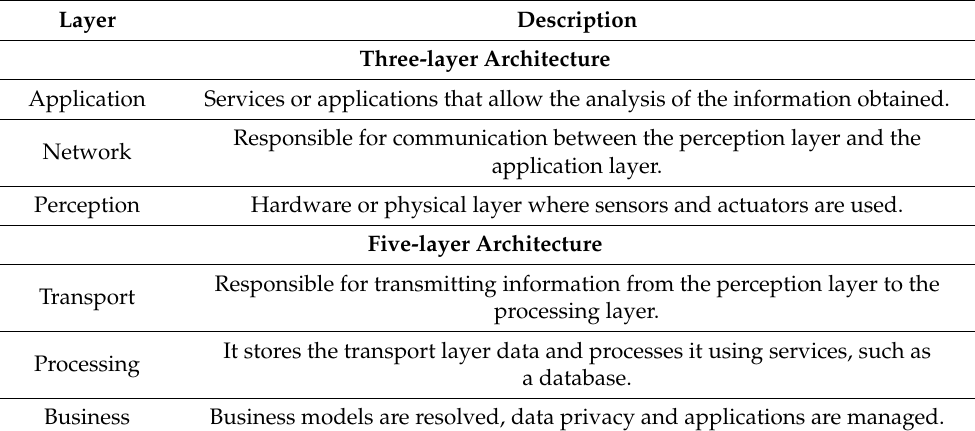
Table 2. IoT architecture based on layering